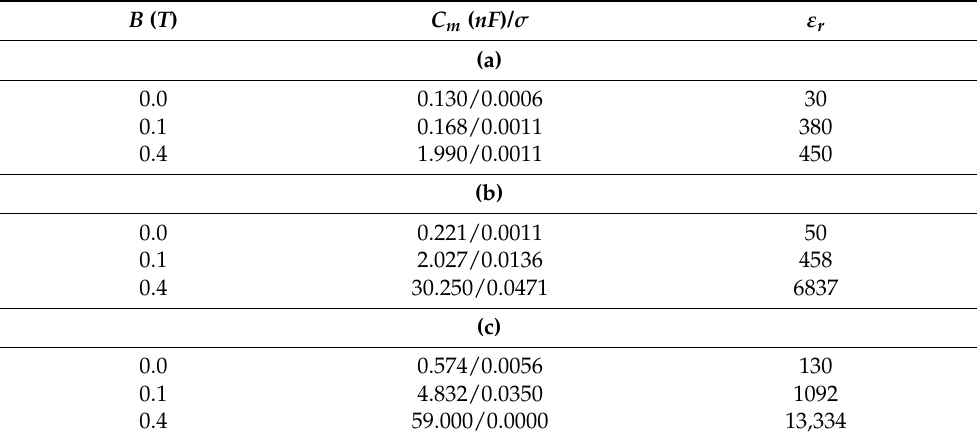
Table 3. ( a ) Electric capacitances ( C m ), standard deviations ( σ ), and relative permittivity of hMRSs, ε r , for Φ Fe = 20 vol.%. ( b ) Electric capacitances ( C m ), standard deviations ( σ ), and relative permittivity of hMRSs, ε r , for Φ Fe = 30 vol.%. ( c ) Electric capacitances ( C m ), standard deviations ( σ ), and relative permittivity of hMRSs, ε r , for Φ Fe = 40